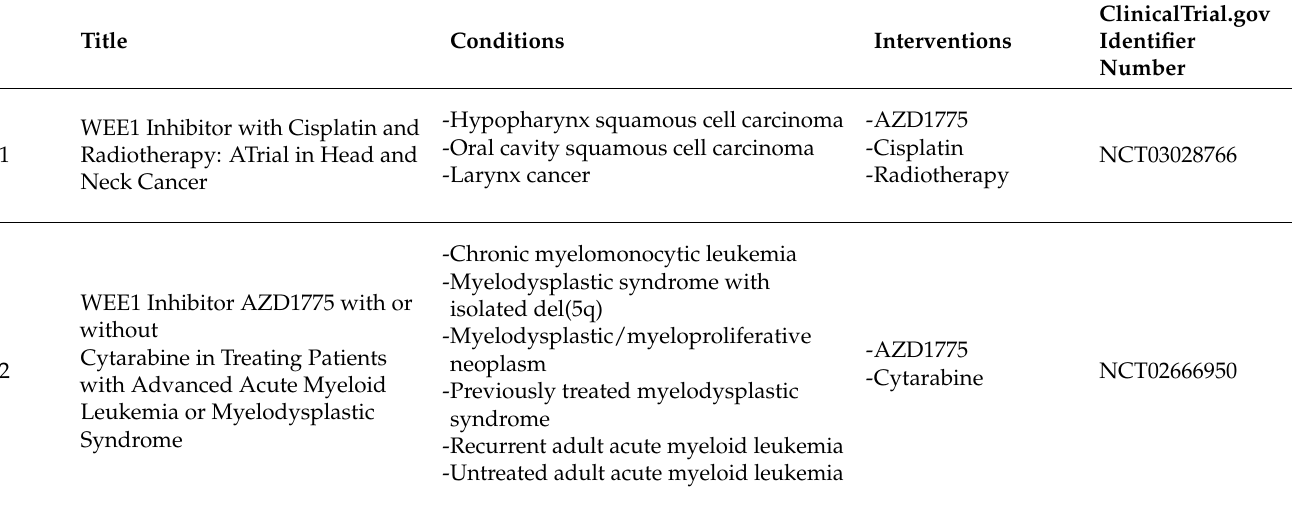
Table 3. Registered clinical trial on Wee1